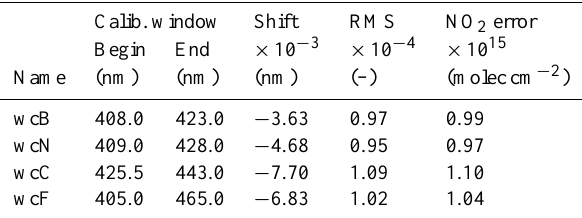
Table 3. Pacific Ocean test orbit average main results of the wave- length calibration and spectral fit, using the v2014 reference spectra for the wavelength calibration windows mentioned in Sect. 4.2.